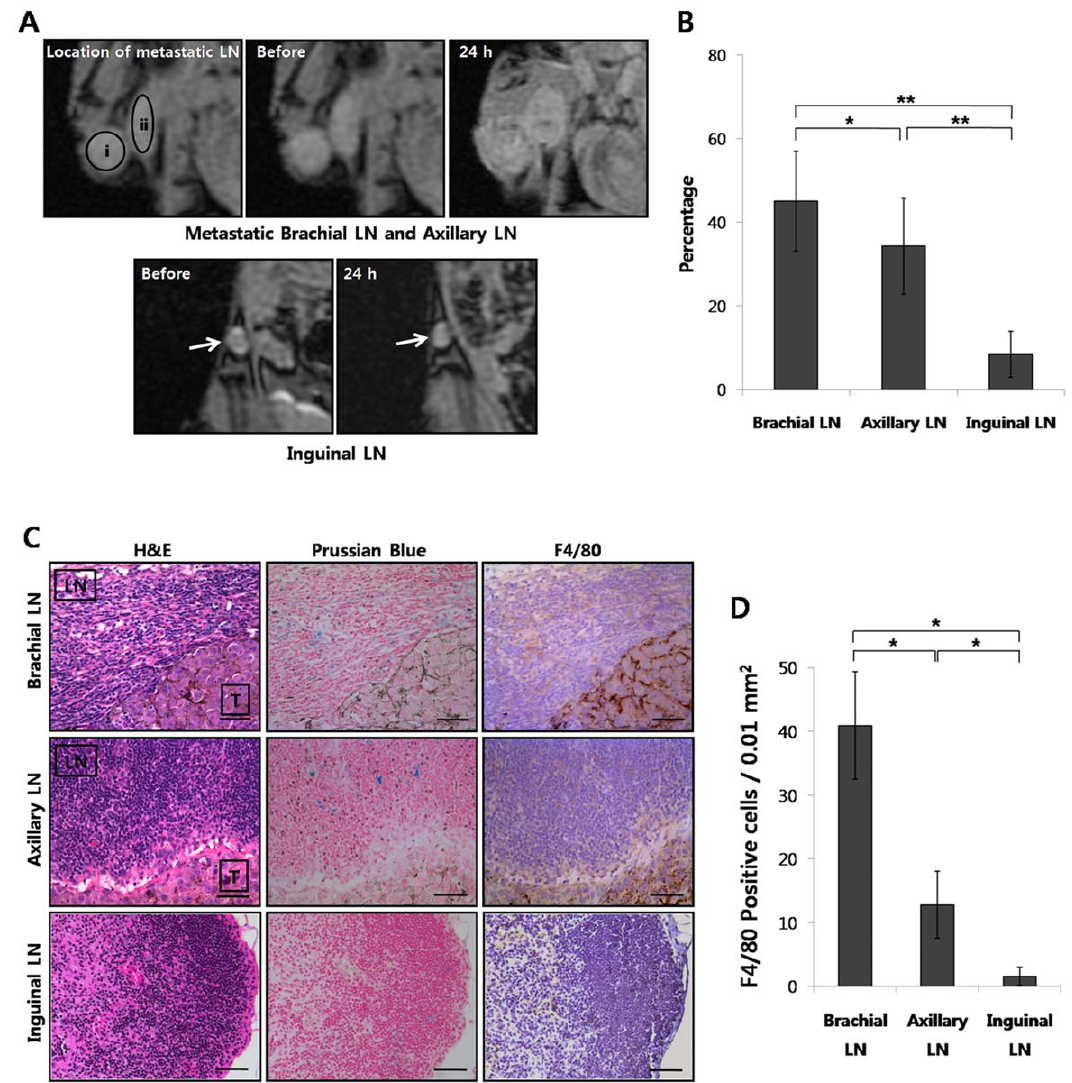
Figure 6. The recruitment of FION-labeled macrophages into metastatic lymph nodes. (A) i and ii represent metastatic brachial and axillary LNs, respectively. Hypointense pixels increased in both the brachial and axillary LNs 24 h after the intravenous injection of FION-labeled macrophages. Non-metastatic inguinal LNs showed fewer hypointensities than the brachial and axillary LNs. (B) The percentages of hypointense pixels within the metastatic brachial and axillary LNs as well as the non-metastatic inguinal LNs were 45.064 6 11.932 (%), 34.242 6 11.456 (%) and 8.413 6 5.449 (%), respectively (* P , 0.05, ** P , 0.001). (C) Prussian blue staining demonstrated an abundant presence of FION-loaded cells within the metastatic LNs (Blue). The FION-labeled macrophages in the LNs stained positively with the F4/80 antibody (Brown). LN=lymph node,